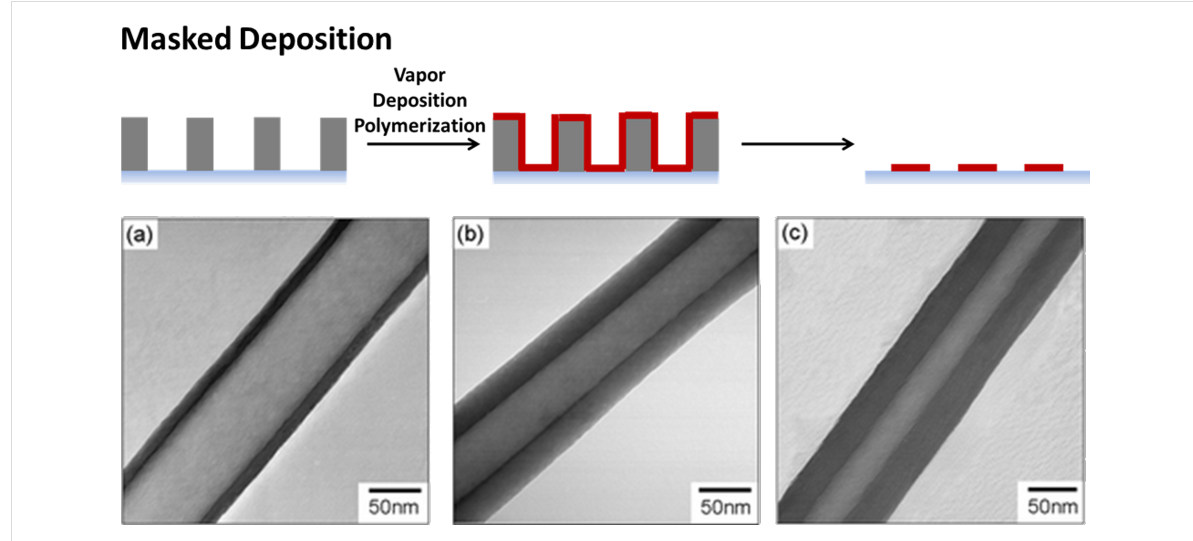
Figure 1: Polymer structures via masked deposition: polypyrrole nanotubes by deposition using aluminum oxide membranes with a pore size of 100 nm as the template. The wall thickness can be varied by variation of the loading amount of monomer (a) 0.07 mL, (b) 0.14 mL, and (c) 0.21 mL. Reproduced with permission from [11], copyright 2004 The Royal Society of